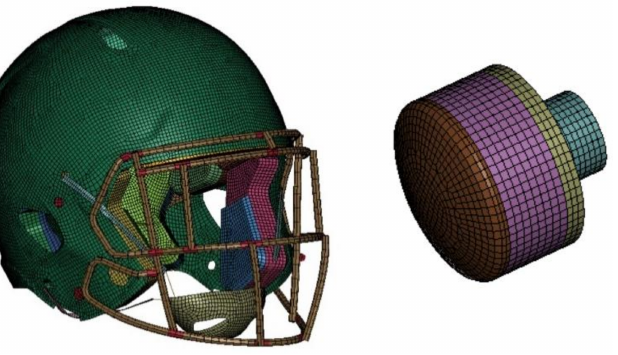
Figure 4. 2016 Riddell Speed Classic helmet and the impactor discrete model used in the study.